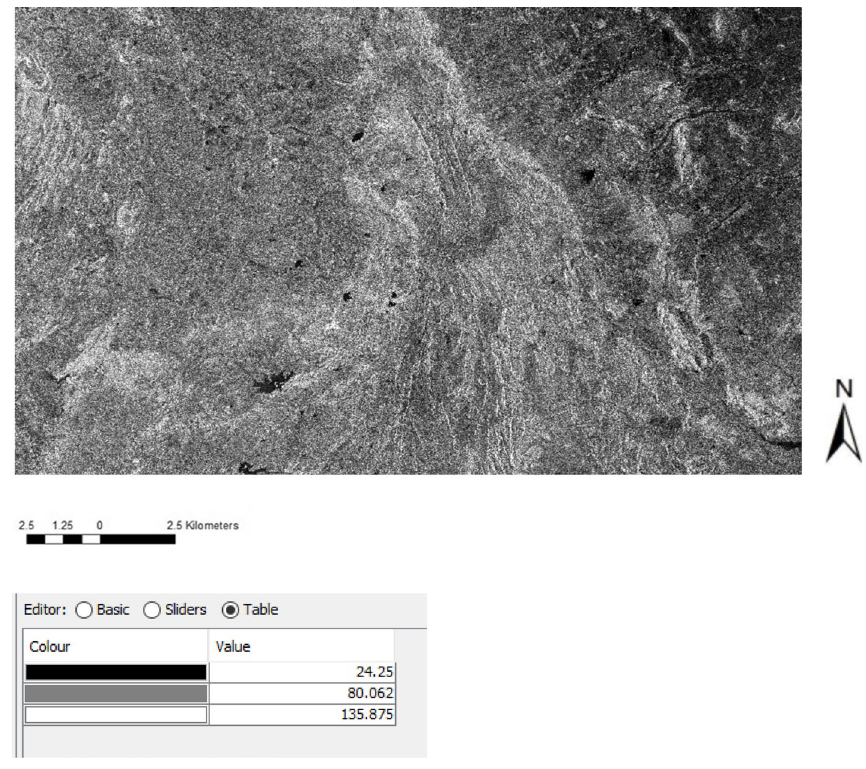
Fig. 6 Sentinel-1A-GRD amplitude data (VH Polarisation) of the Udaipur